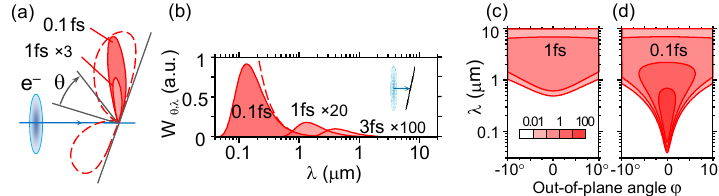
Fig. 2. Frequency-angular spectra of CTR for (cid:2028) = 3 fs, 1 fs and 0.1 fs (shaded areas) and corresponding single-particle spectra (dashed curves) in the properly tilted geometry (α = 18  , optimizes emission at (cid:2016) = 68°). Bunch transverse radius (1/e) is 3 µm. (a) Radiation patterns at (cid:2019) = 1 µm. (b) Spectra at (cid:2016) = 68°. (c) Out-of-plane emission distribution at (cid:2016) = 68°, (cid:2028) = 1 fs. (d) The same but for (cid:2028) = 100